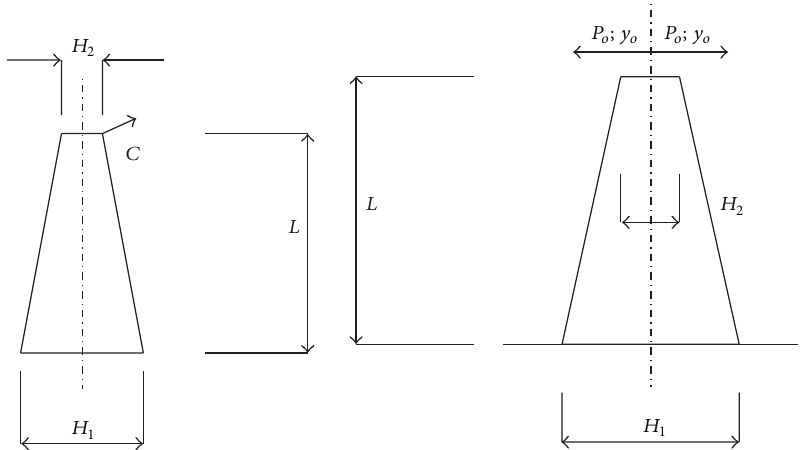
Figure 1: Shape of samples for complex modulus testing.